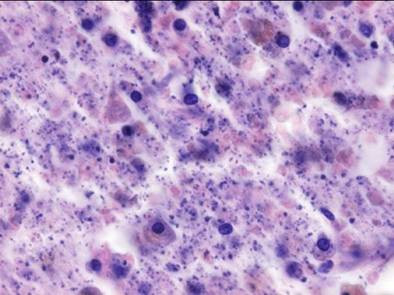
Bacterial proliferation in the cerebral infarction.